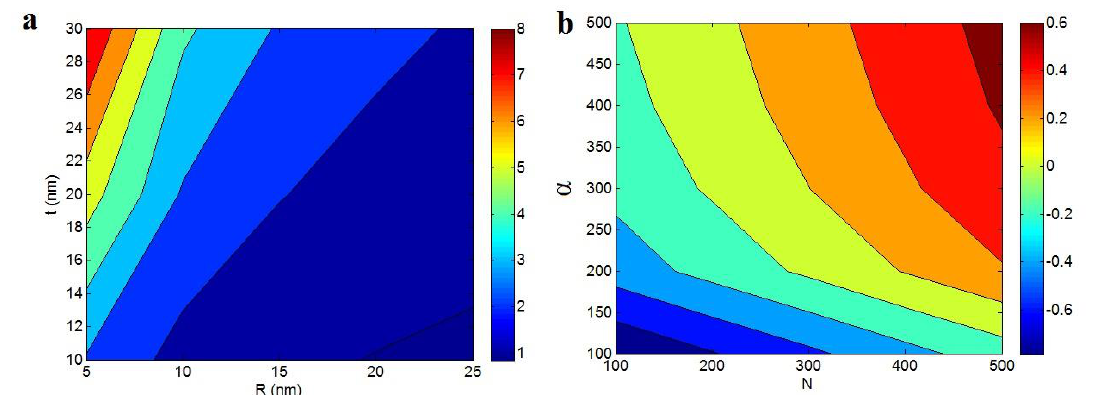
Figure 2. The contour plots for ( a ) “ S I ” as a function of “ R ” and “ t ” parameters at σ m = 40 MPa, α = 300 and σ N = 5000 MPa and ( b ) dependence of “ S N ” on “ N ” and “ α ” parameters at σ m = 40 MPa and σ N = 5000 MPa.